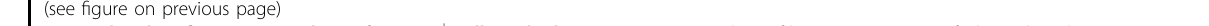
Fig. 3 Gli1 identi fi es a minor subset of EpCAM + cells in the liver. a RNAscope analysis of hepatic expression of Gli1 (red) and EpCAM (green) or CK19 (green) on 8-week-old WT mice. Scale bars, 200 μ m. b Experimental design for lineage tracing of Gli1 + cells using Gli1-Cre ERt2 ;Ai9 mice. c Immunostaining for tdTomato (red) and EpCAM (green), PDGFR α (green) or α -SMA (green) on liver sections (left panels). White arrowheads indicate the co-stained cells. Scale bars, 50 μ m. Quanti fi cation of the percentage of tdTomato + cells expressing PDGFR α , EpCAM, and α -SMA (right panels). Data are presented as means ± SEM ( n = 3). d Immunostaining for tdTomato (red), EpCAM (white), and PDGFR α (green) or α -SMA (green) in liver sections. PV portal vein. White arrowhead indicates the co-stained cell. Scale bars, 50 μ